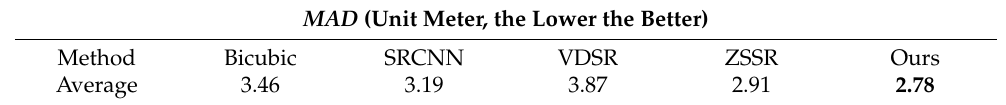
Table 8. MAD for the test